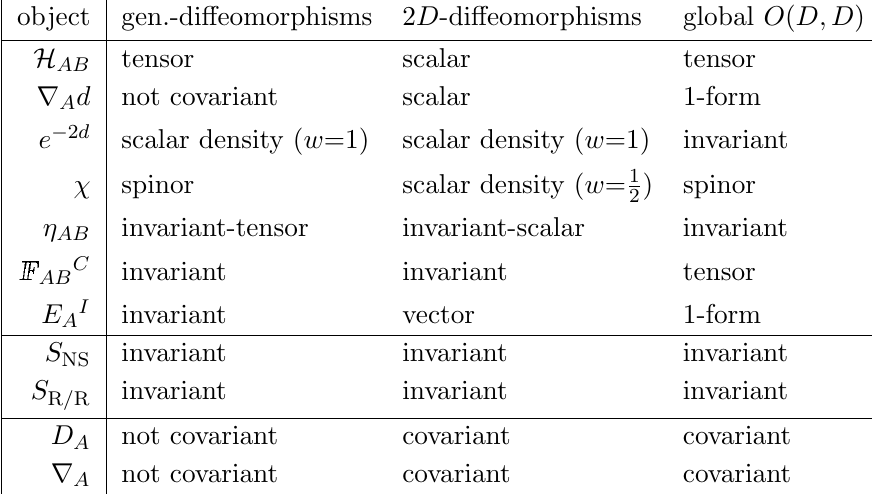
Table 1 . Transformation properties of objects under DFT WZW